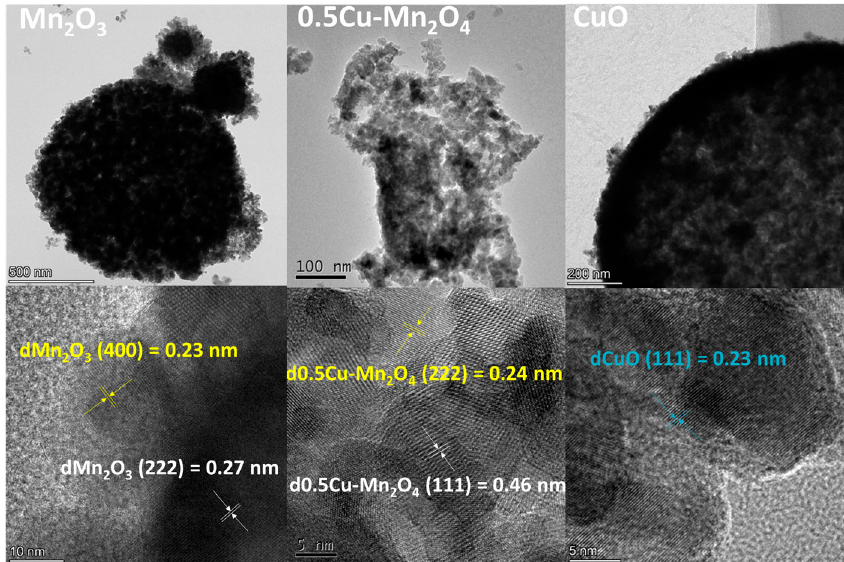
Figure 5. HRTEM images of each catalyst.